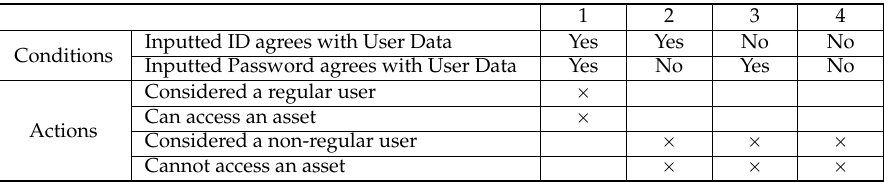
Table 1. Decision Table (Password Design and Use pattern).